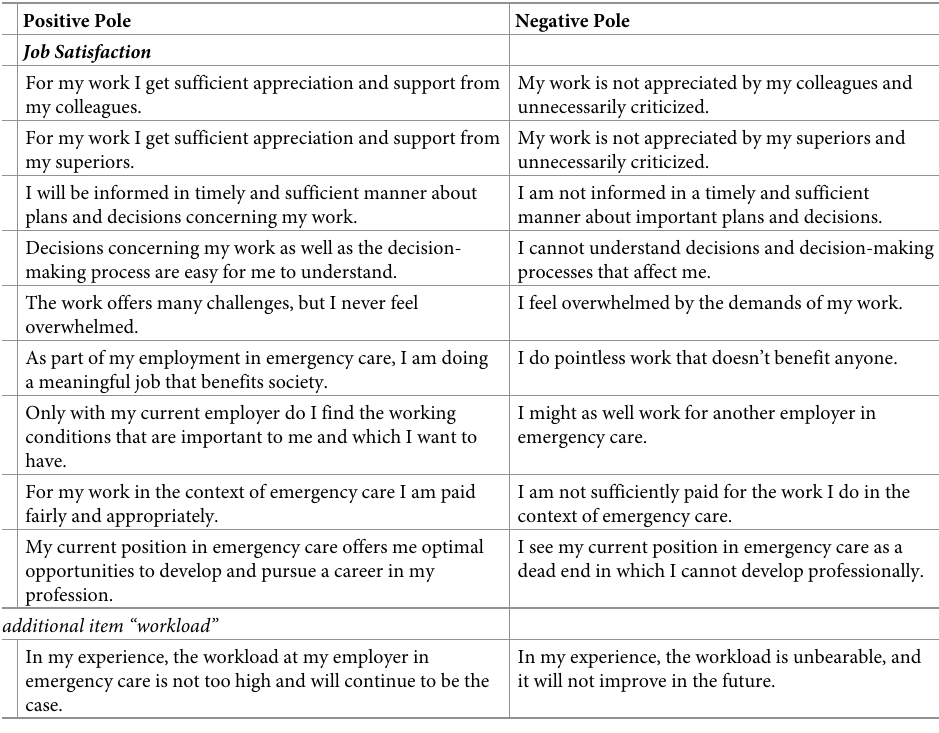
Table 2. Polarity profile for job satisfaction and workload. Positive Pole